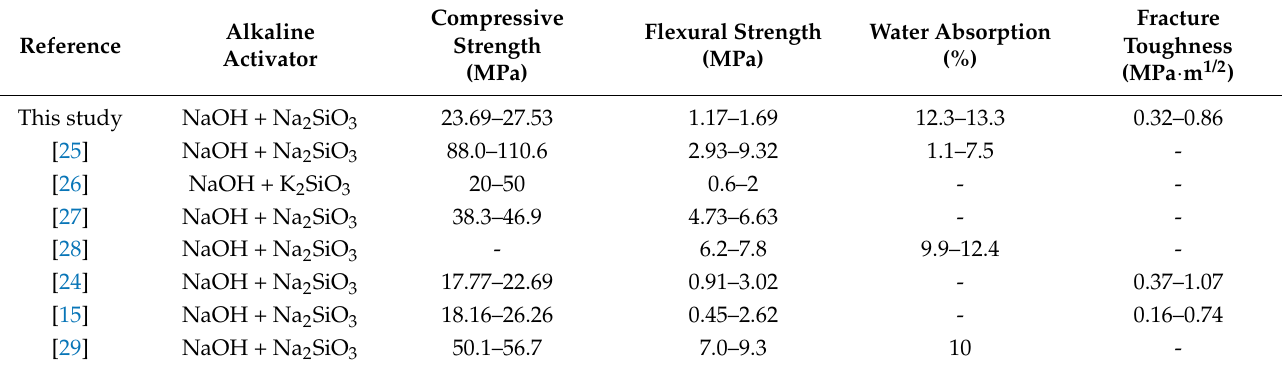
Table 3. The comparison of mechanical strength across studies.